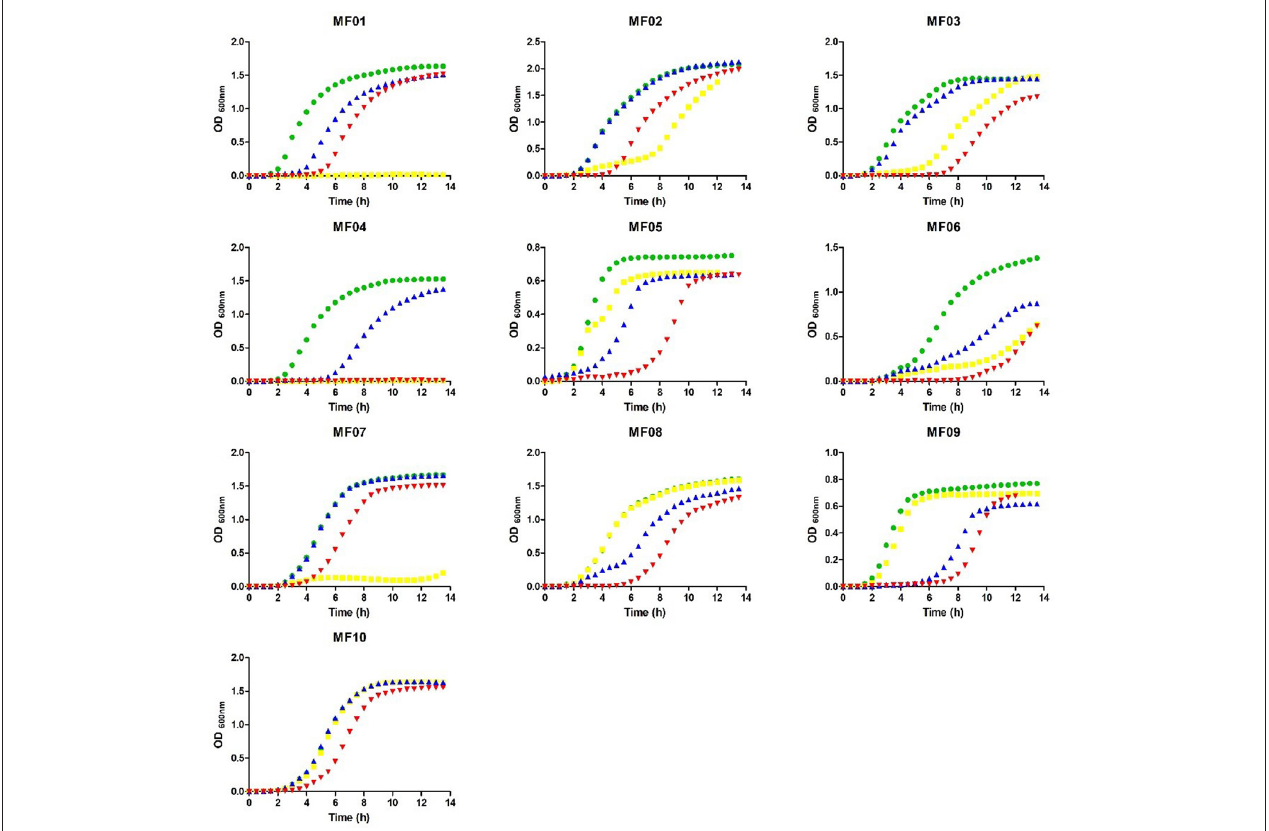
FIGURE 2 | Growth curves of the environmental multi-metal(loid) resistant bacteria exposed to TeO 2 − 3 , AuCl − 4 , and Ag + . Cells were grown in LB medium in the absence (green) or presence of 4 µ M TeO 2 − 3 (yellow), 15 µ M AuCl − 4 (blue), or 15 µ M Ag +